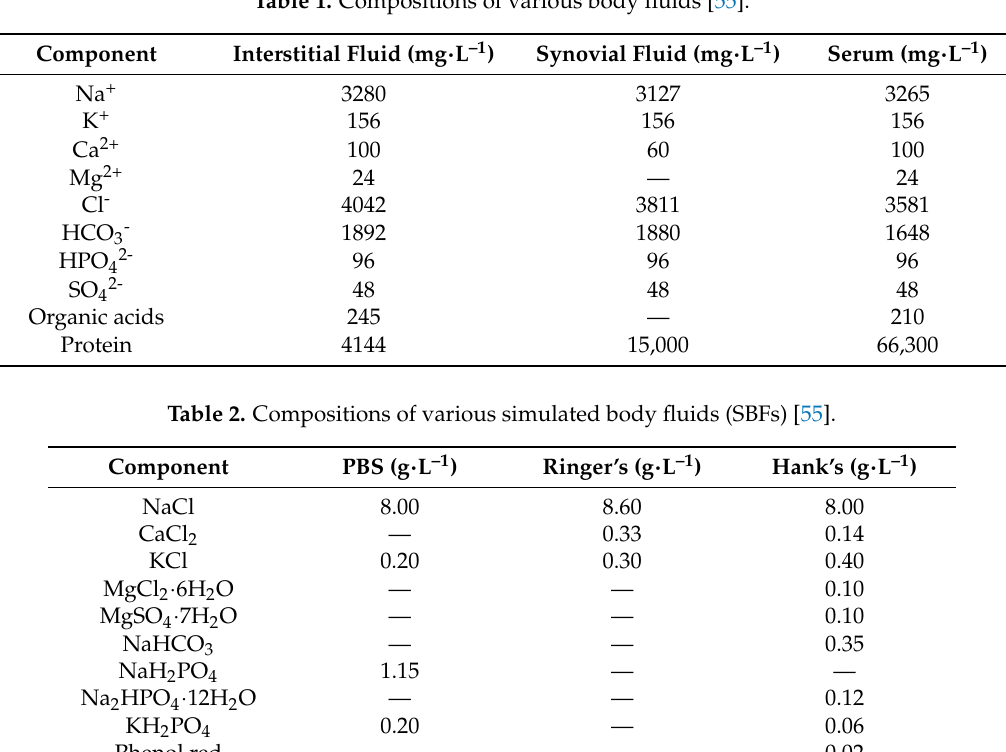
Table 1. Compositions of various body fluids [55].